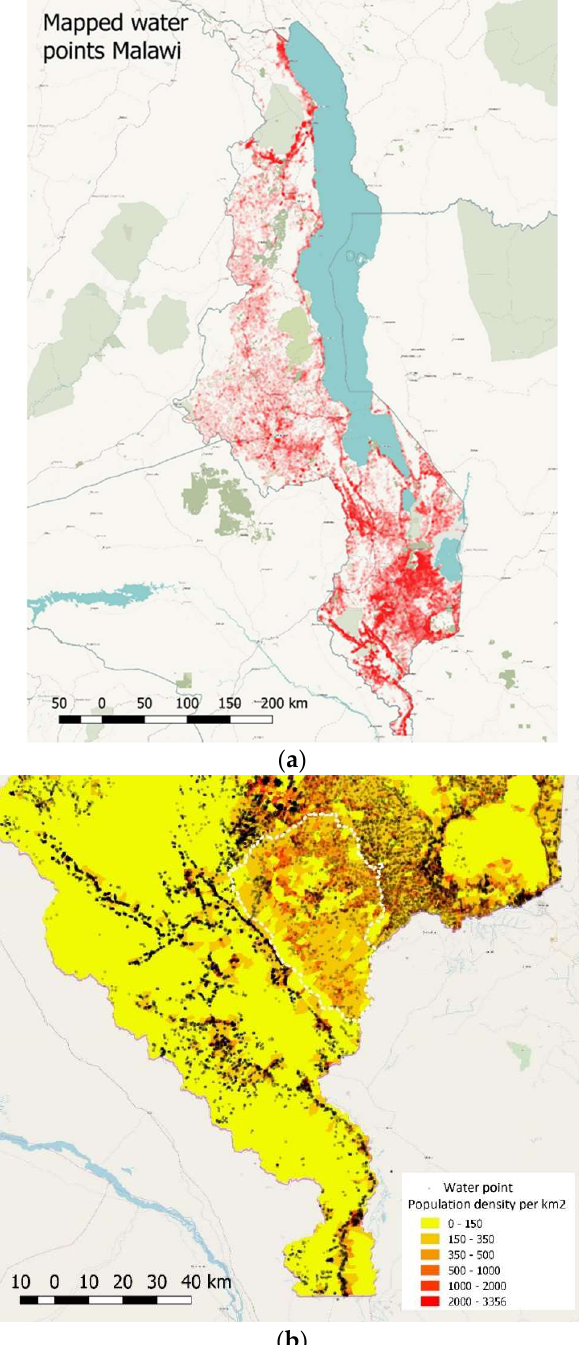
Figure 6. ( a ) Water points in Malawi extracted from the Madzi Alipo, WPDx, OSM, DoIWD, DoS, MCRS, 510, PCI and CJF data sources; ( b ) Water points in relation to population density in Southern Malawi (source: MASDAP, 2014).